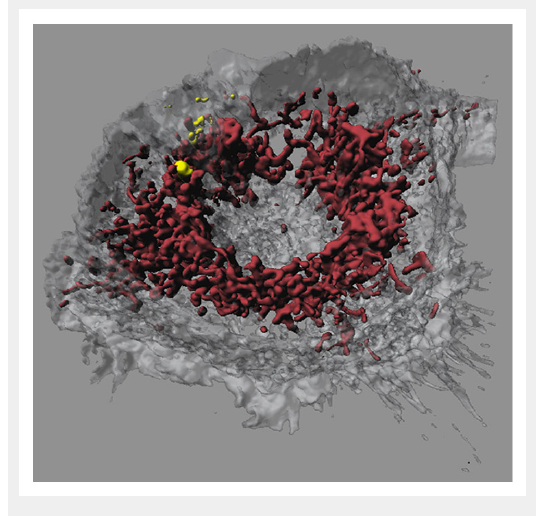
Confocal laser scanning microscopy image of a macrophage that had taken up iron-platinum nanoparticles. Fluorescent labelling of mitochondria using MitoTracker (bordeaux) reveals that the fluorescently labelled polymer-coated iron-platinum nanoparticles (yellow) do not colocalise with mitochondria in macrophages (white, transparent). Image adapted and reproduced with permission from: Lehmann AD, Parak WJ, Zhang F, Ali Z, Röcker C, Nienhaus GU, et al. Fluorescent–magnetic hybrid nanoparticles induce a dose- dependent increase in proinflammatory response in lung cells in vitro correlated with intracellular localization. Small. 2010;6(6):753-62